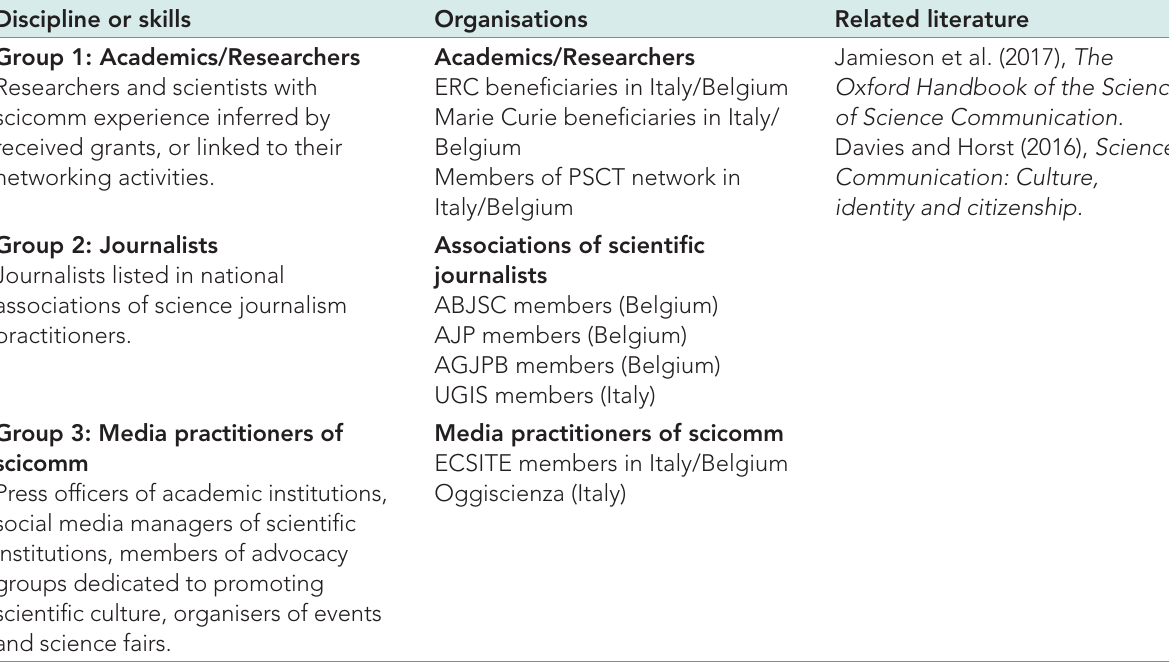
Table 1. Universe for the selection of participants in the Delphi panel, based on the Knowledge Resources Nomination Worksheet (KRNW) (Source: Adapted from Okoli and Pawlowski, 2004: 8)